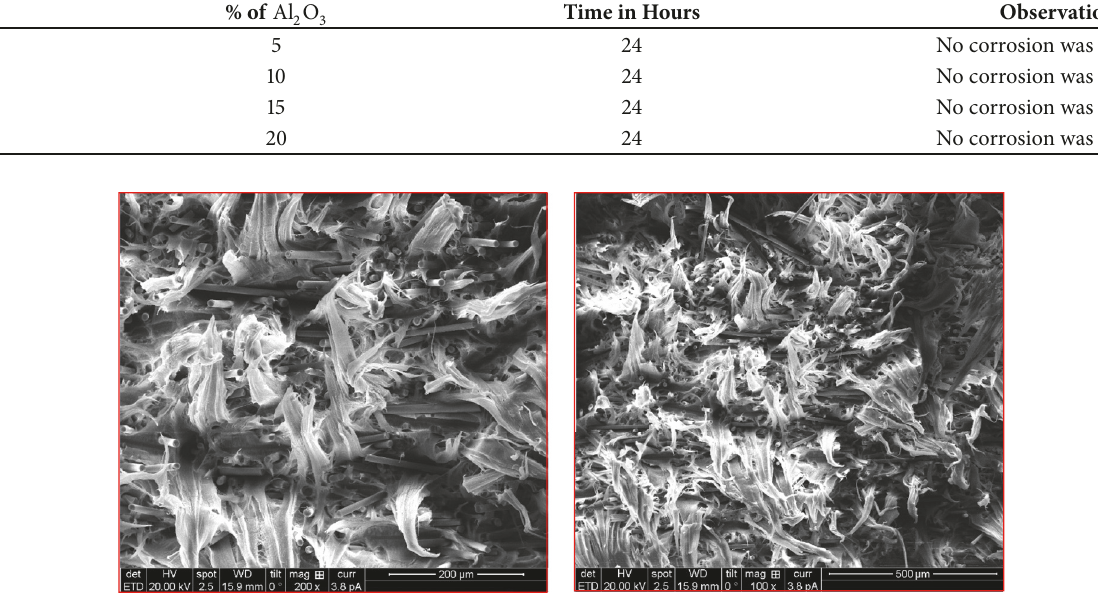
Figure 8: Fractured surface after tensile strength test for HDPE/20% Al 2 O 3 .